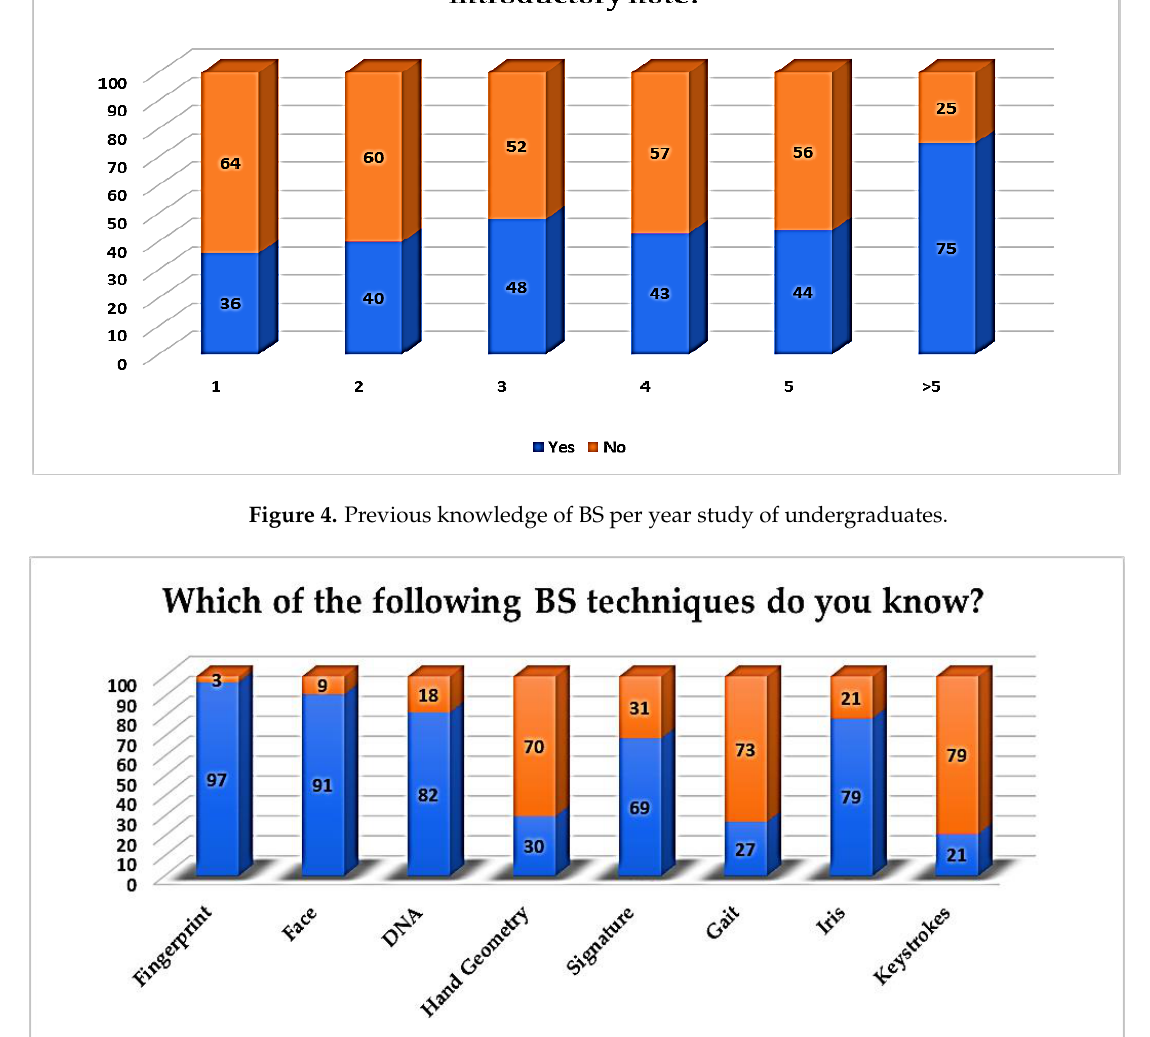
Figure 4. Previous knowledge of BS per year study of undergraduates .